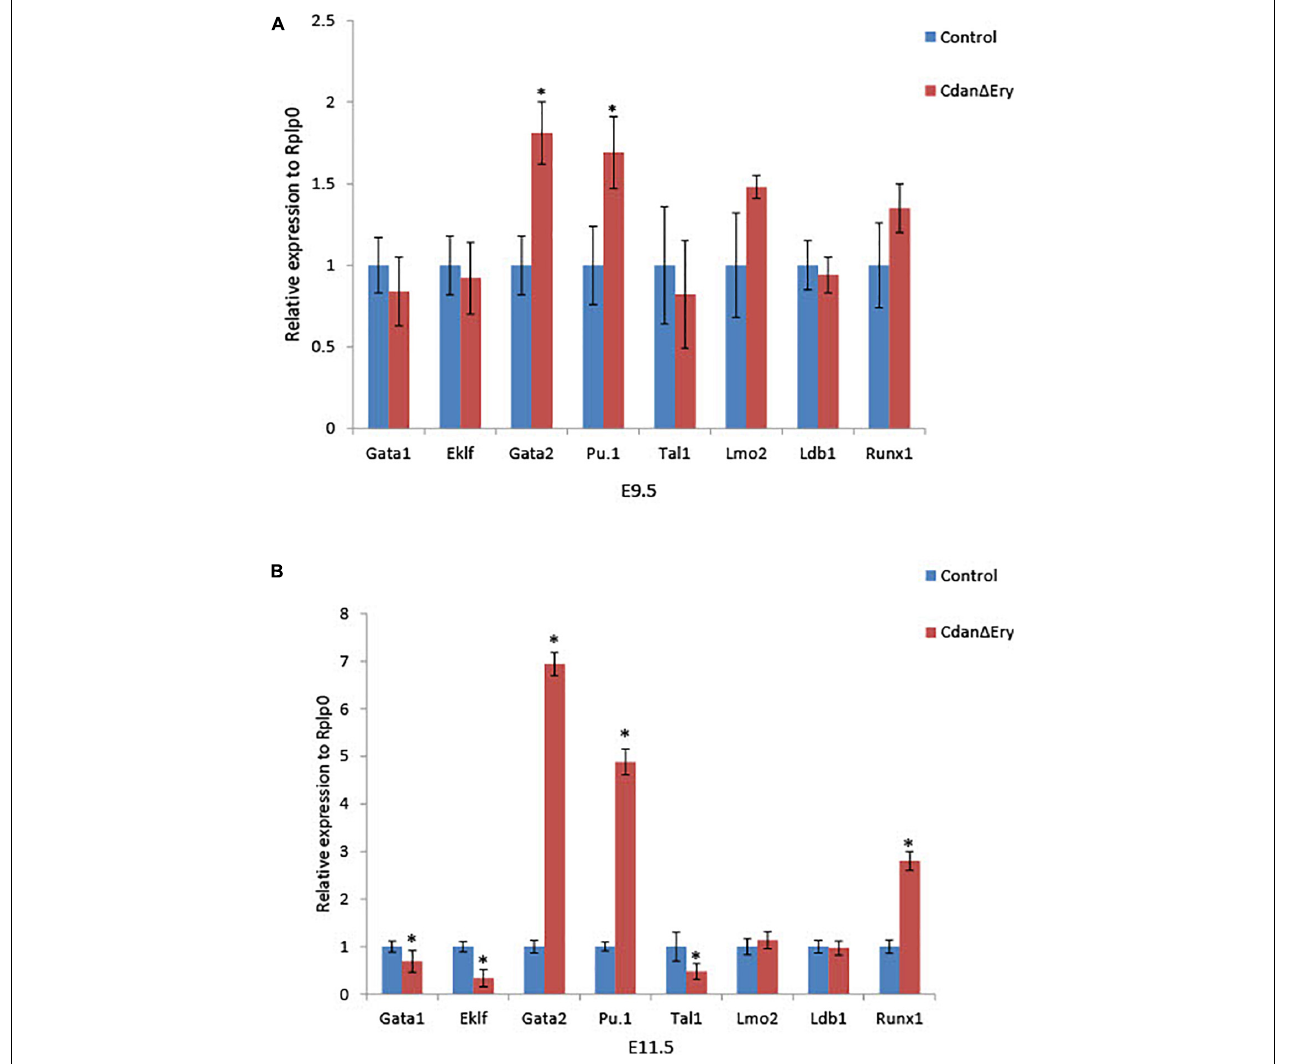
FIGURE 7 | Cdan1 ablation disrupts expression of master erythroid transcription factors. qRT-PCR was performed with RNA extracted from peripheral blood cells at E9.5 and E11.5, and normalized to Rplp0. Relative expression data are presented as mean ± SEM ( n = 4–7 for each genotype). Student’s t- test was applied for statistical analysis. Asterisks indicate significant difference from the control. ∗ p < 0.01 (A) Relative expression in E9.5 Cdan (cid:49) Ery circulating erythroblasts compared to littermate controls. (B) Relative expression in E11.5 Cdan (cid:49) Ery circulating erythroblasts compared to littermate